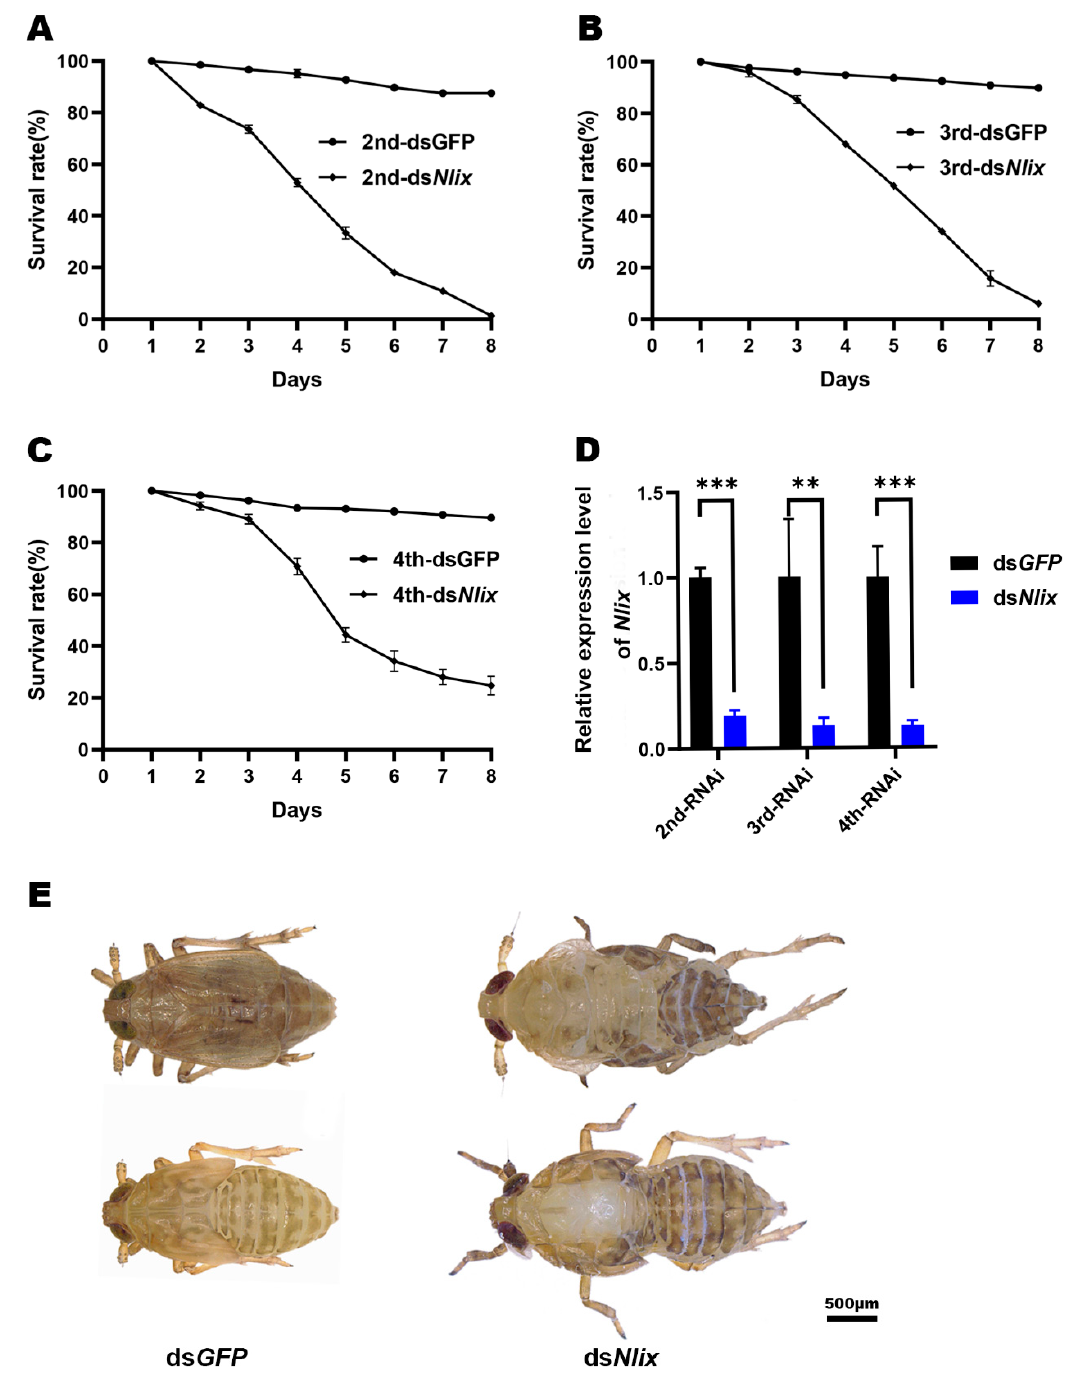
Figure 4. Effects of dsNlix treatment on nymph development. ( A – C ) Survival rates after the knockdown of Nlix . ds GFP was used as the negative control in each group. ( A ) 2nd instar nymphs after dsRNA treatment; ( B ) 3rd instar nymphs after dsRNA treatment;( C ) 4th instar nymphs after dsRNA treatment. ( D ) Transcript levels of Nlix after RNAi treatment in the 2nd, 3rd and 4th instar nymphs. The RNAi efficiency of Nlix was evaluated by collecting 6 to 10 insects three days after injection. Means ± SEM from three experiments. ** p < 0.01, *** p < 0.001 (Student’s t -test). ( E ) The lethal phenotype of N. lugens injected with ds Nlix in nymph stages . Most nymphs die of molting failure.